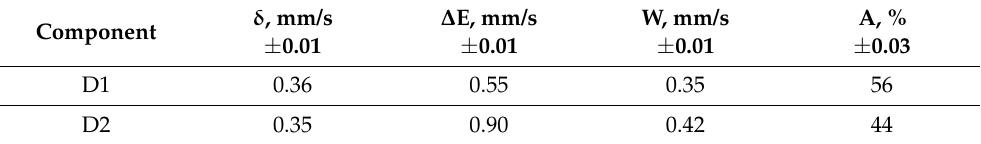
Table 1. Parameters of Mössbauer spectrum for iron-modified microgel with η = 10.5 wt. % at 298 K.